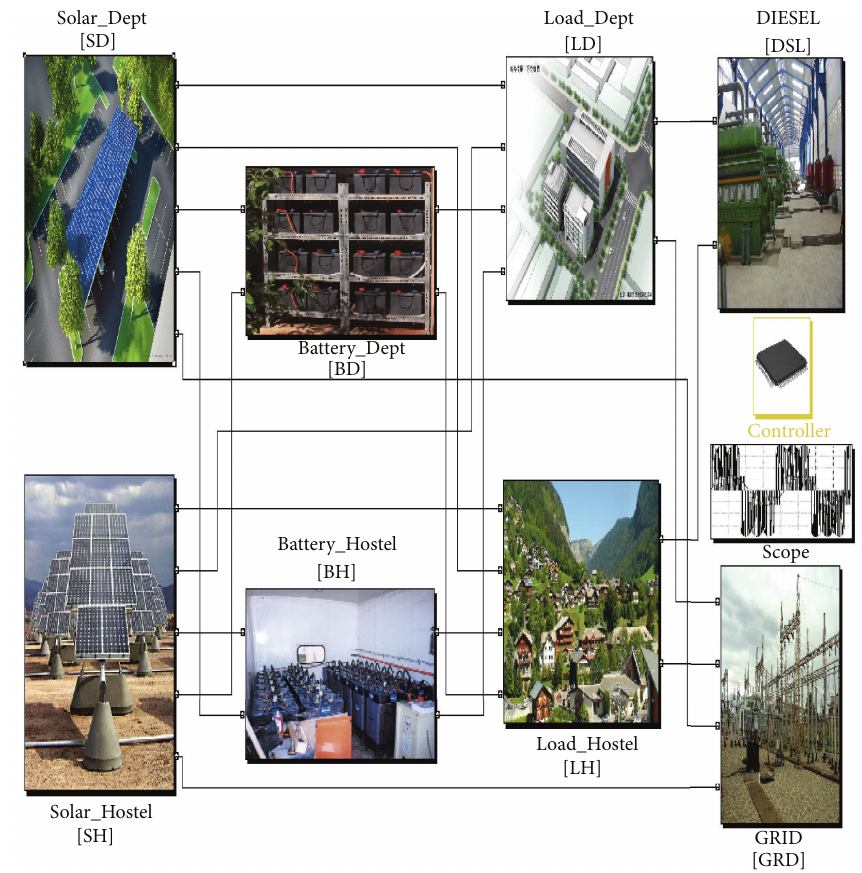
Figure 10: Simulink model of solar